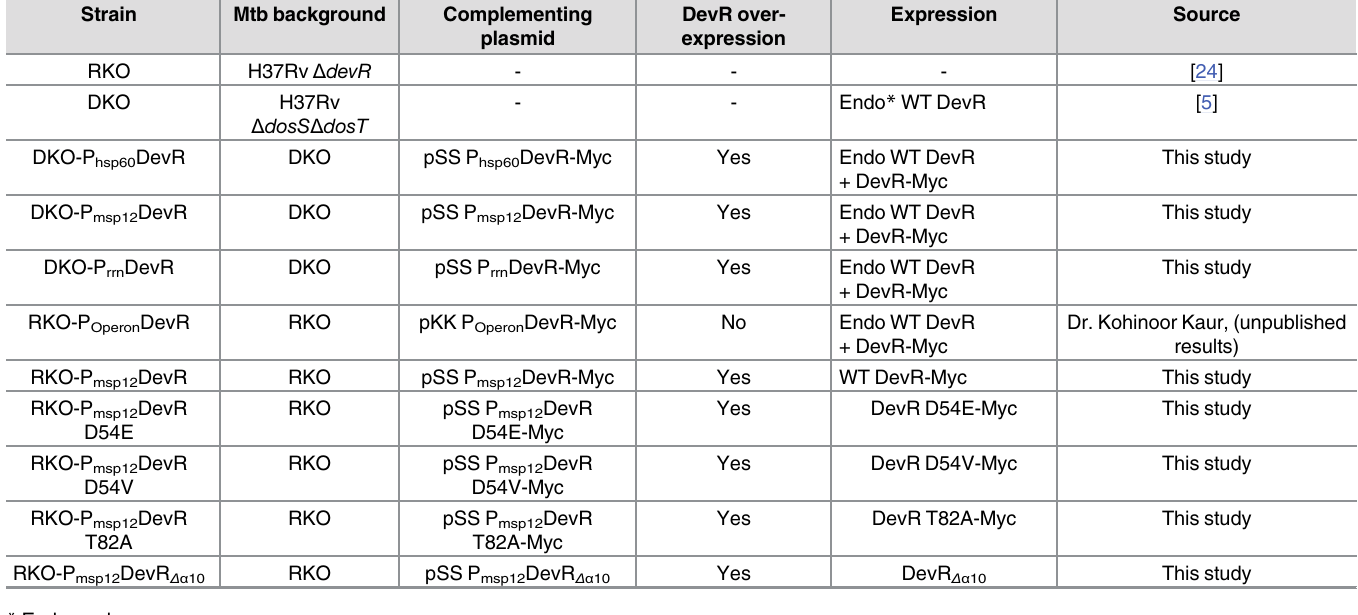
Table 1. Mtb strains used in the study. Strain Mtb